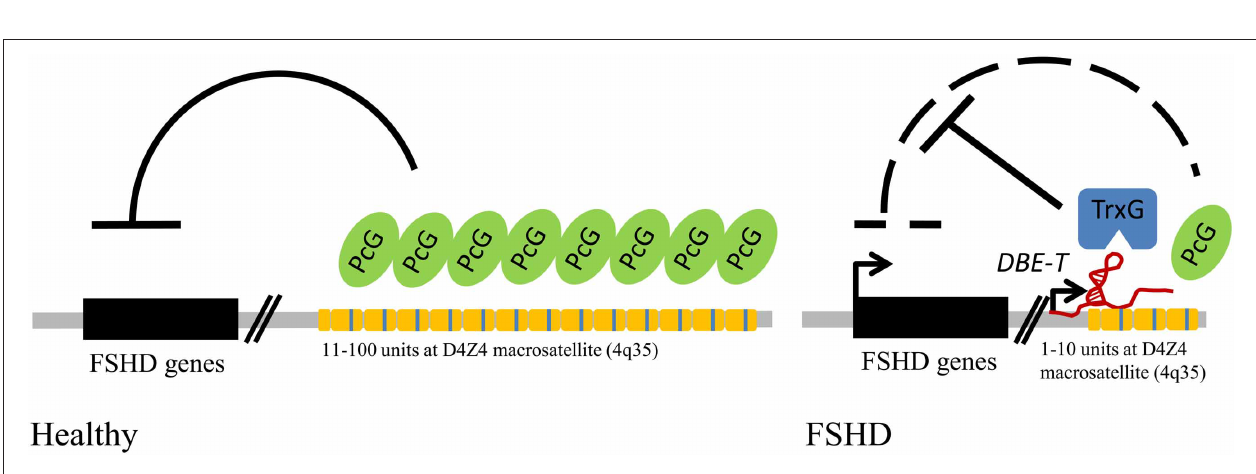
RepA recruits PRC2, creating the conditions for the production of the full-length Xist RNA (1) . Xist co-transcriptionally binds PRC2 via its R-A region, and it is loaded onto chromatin (2) . YY1 functions as a bridge and anchors Xist in cis , by binding both Xist RNA and DNA, respectively via their Repeat C (R-C) and Repeat F (R-F) regions (3) . Xist RNA, first bound only on the nucleation center, spreads in cis and recruits PRC2, thus mediating the X-chromosome inactivation (4) .